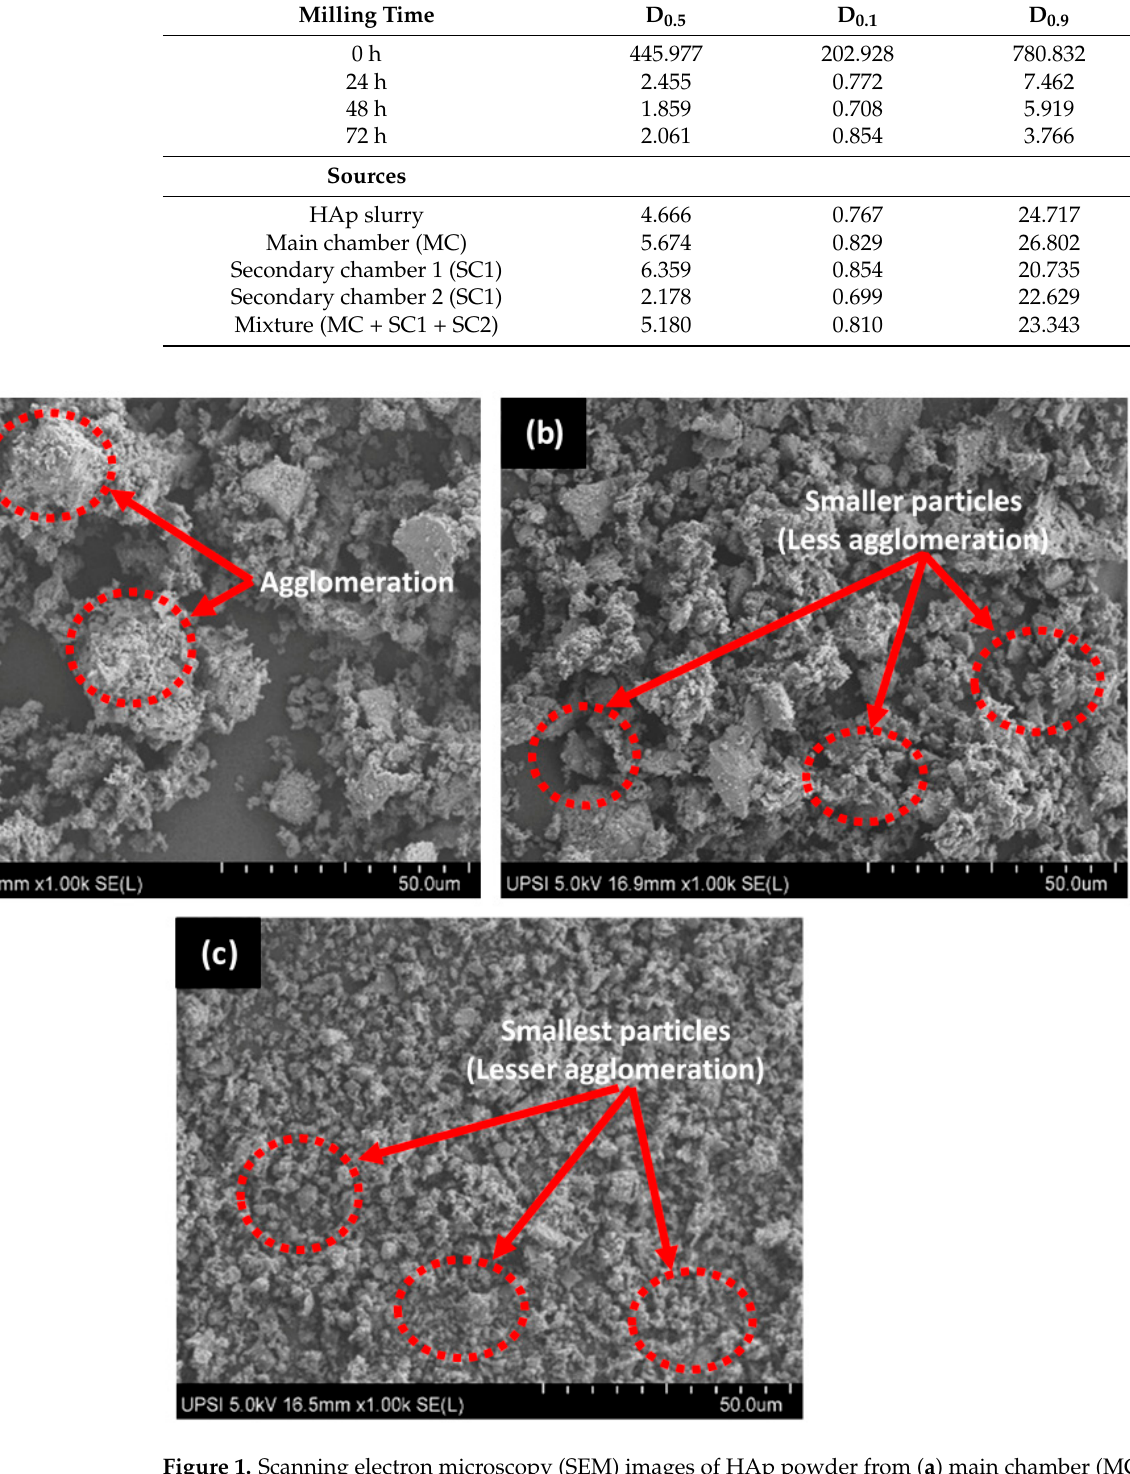
Figure 1. Scanning electron microscopy (SEM) images of HAp powder from ( a ) main chamber (MC) ( b ) secondary chamber (SC1), and ( c ) secondary chamber (SC2). Table 3. Density of the HDPE/HAp composites.